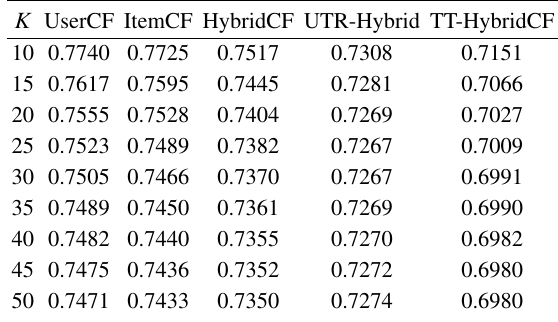
Experiment 5: Comparison of TT-ItemCF with Table 3 MAE values of UserCF, UTR-UserCF, and TT- UserCF algorithms